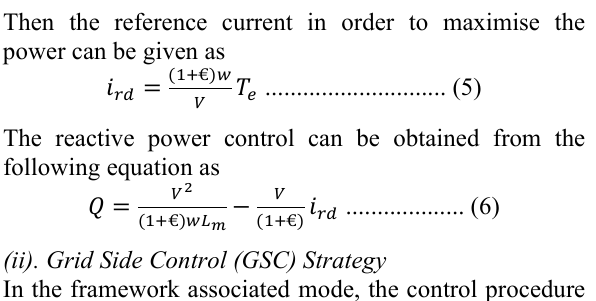
Figure 3. DC link voltage